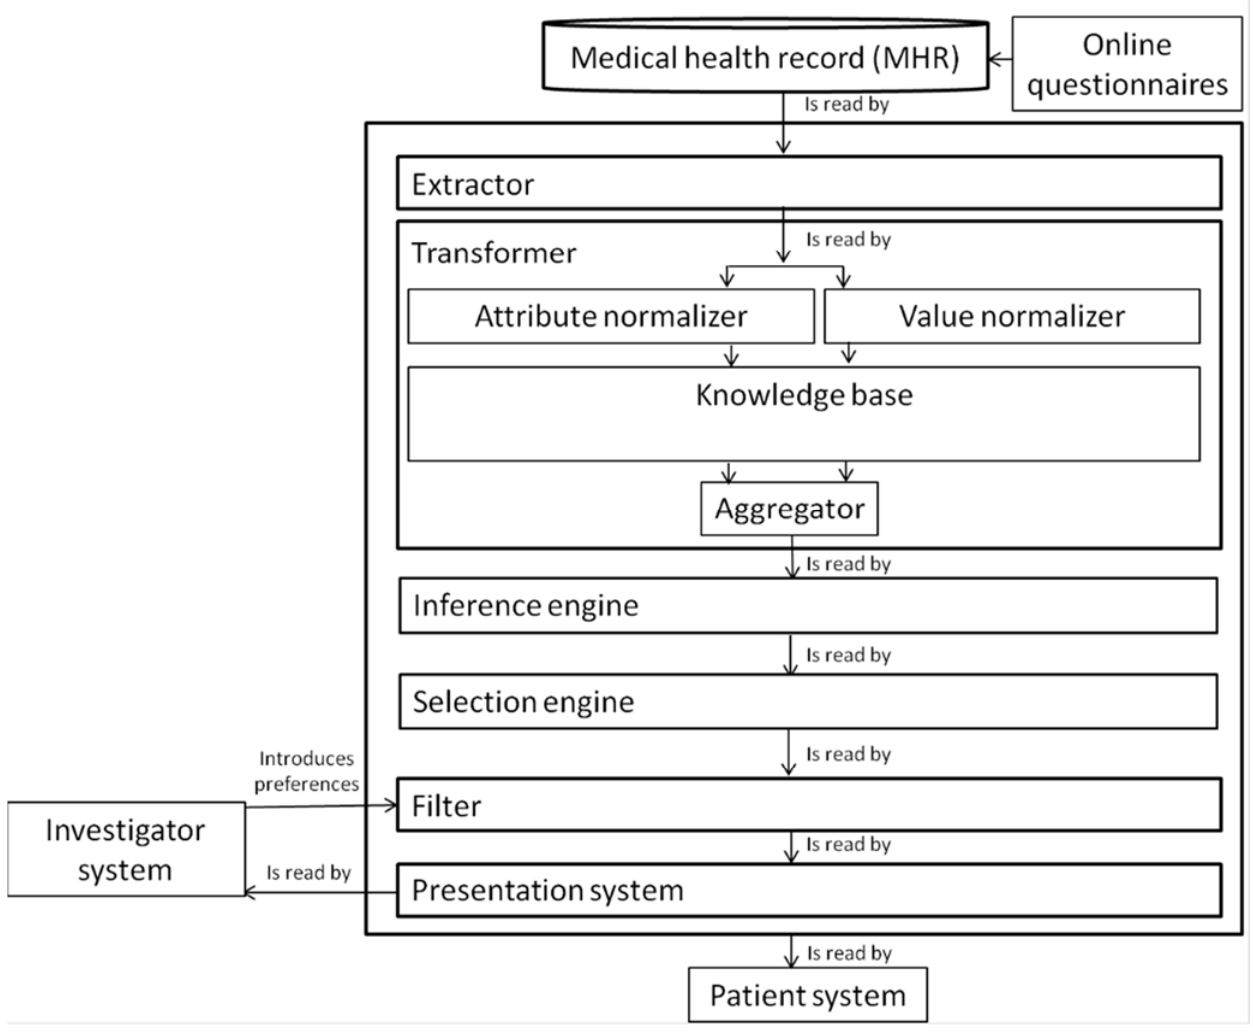
Figure 1. Flowchart of the automatic generation of multidimensional